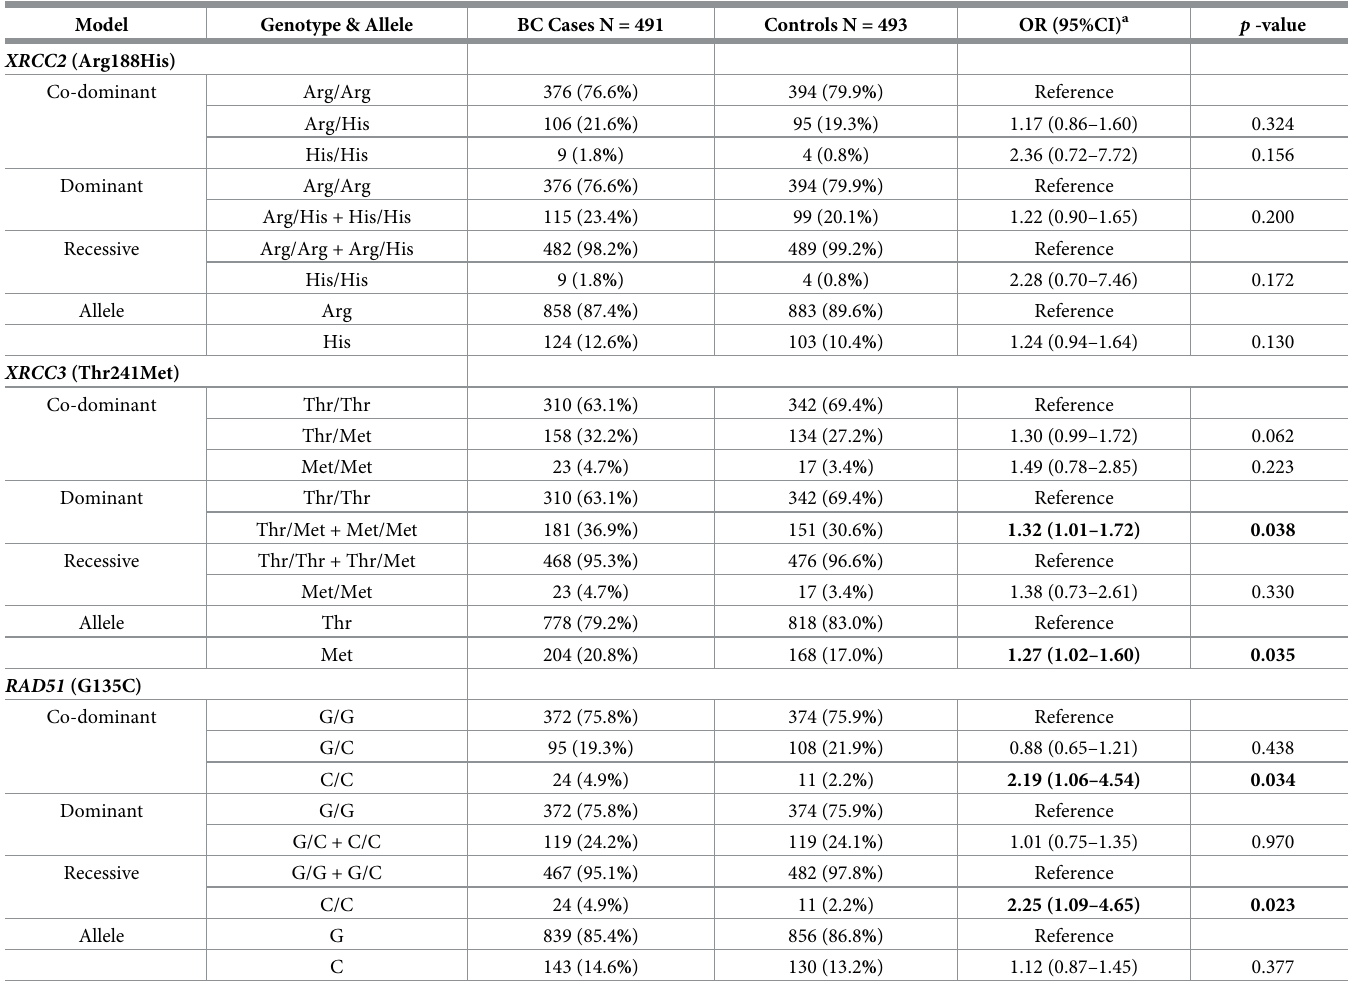
Table 3. Allele and genotype frequencies of XRCC2 , XRCC3 and RAD51 polymorphisms in BC cases and controls.